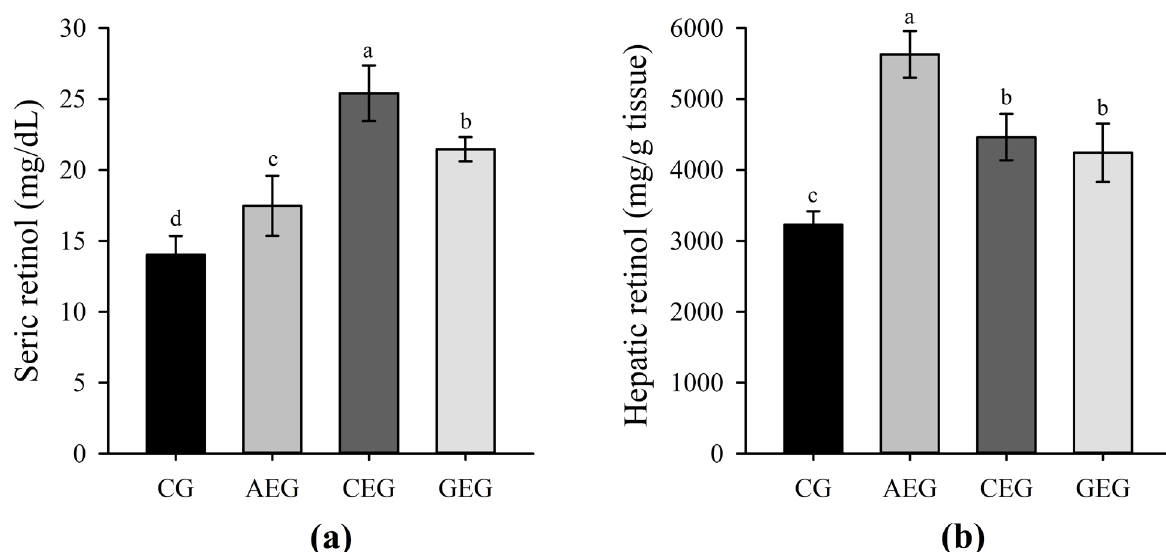
Figure 4. Serum (a) and hepatic retinol (b) of rats supplemented or not with acerola, cashew, or guava by-products. a,b,c,d Different lowercase letters in vertical bars indicate a significant difference between the mean ± standard deviation of each rat group (one-way ANOVA, P ≤ 0.05, Tukey’s post hoc test; n = 8 rats/group). CG = control group; AEG= acerola by-product experimental group; CEG = cashew by-product experimental group; GEG= guava by- product experimental